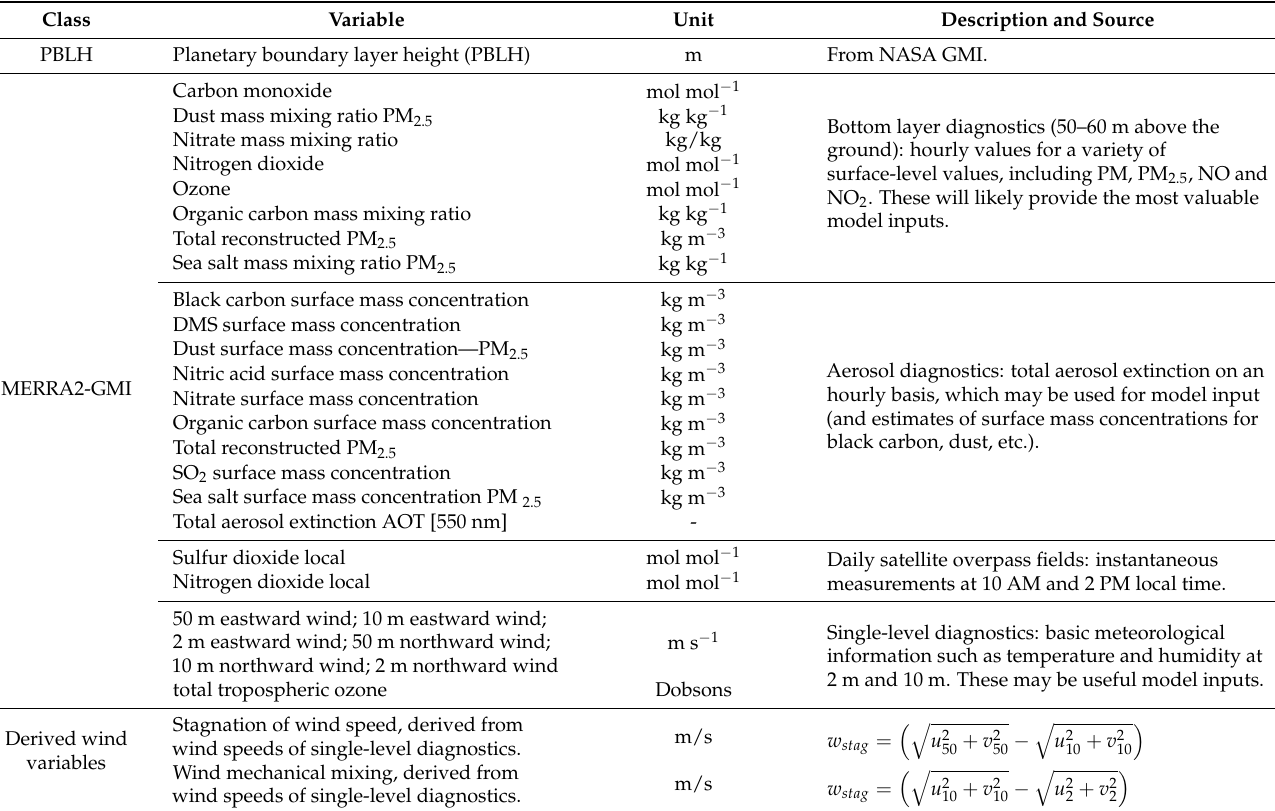
Table A1. MERRA2 and MERRA2-GMI covariates for PM